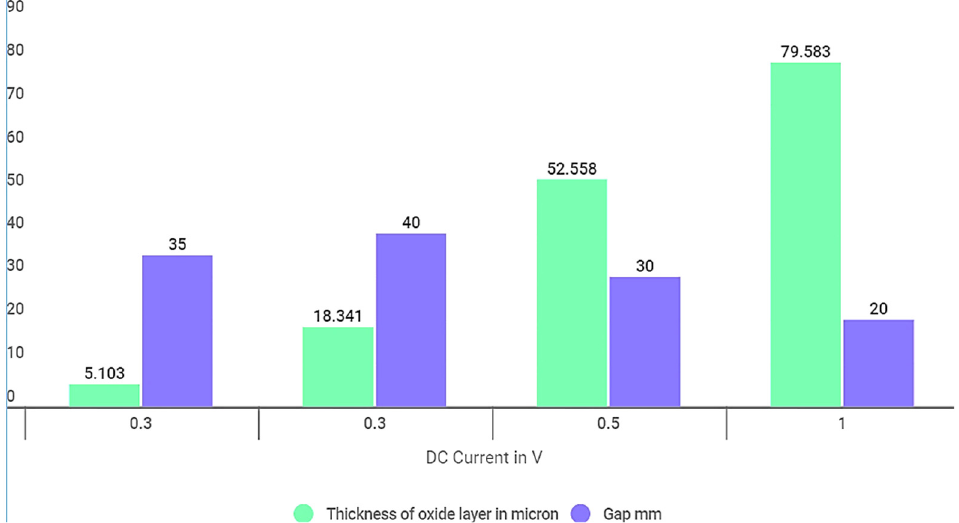
Figure 5. Effect of distance between electrodes and voltage on average oxide layer thickness during the PEO process.